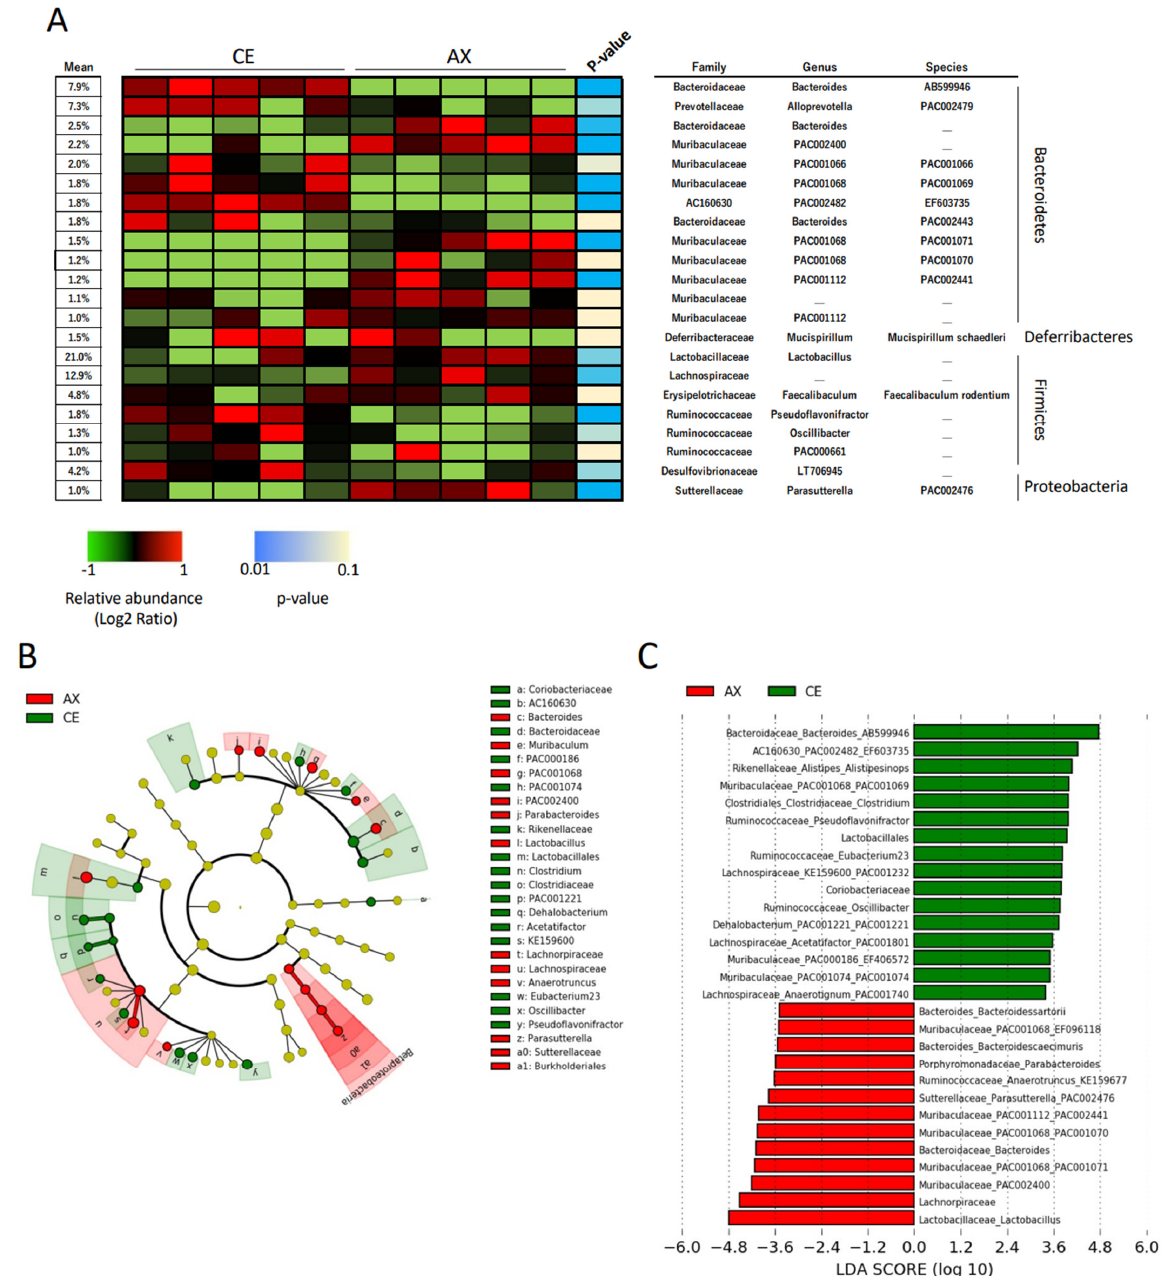
Figure 2. Relative abundance of the gut bacteria at the family, genus, and species levels: ( A ) The effects of AX on the relative abundance of shared bacterial taxa (n = 5). Bacterial taxa with a mean relative abundance greater than 1% are shown in the heatmap. Blue and light blue represent a statistical significance between the CE and AX groups; yellow indicates no statistical difference. ( B , C ) Graphics of linear discriminant analysis (LDA) effect size (LEfSe) for the bacterial taxa responsive to AX. A cladogram ( B ) and horizontal bar plot ( C ) depicting the results of the LEfSe analysis for each taxon. The length of the bar represents the log10-transformed LDA score. Bacterial taxa with a mean relative abundance greater than 1% were subjected to LEfSe analysis. Bacterial taxa abundant in the feces of the AX-fed mice are shown in red and those of the CE-fed mice are shown in green.